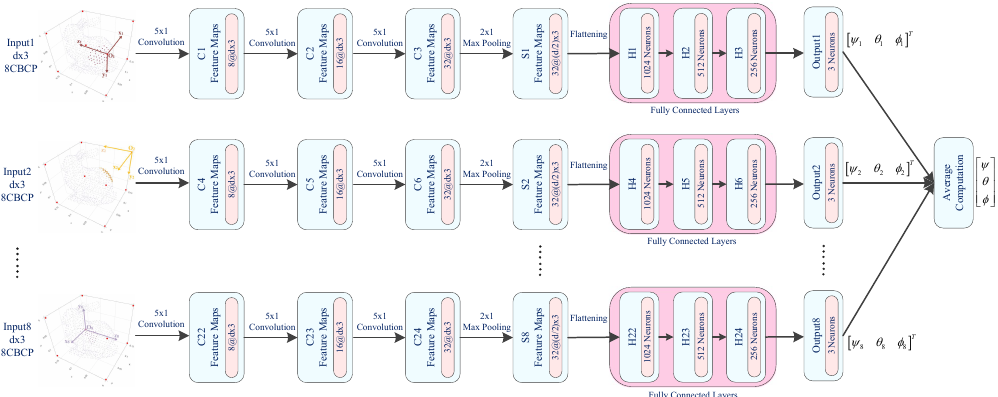
Figure 9. A 2-D architecture for the precise